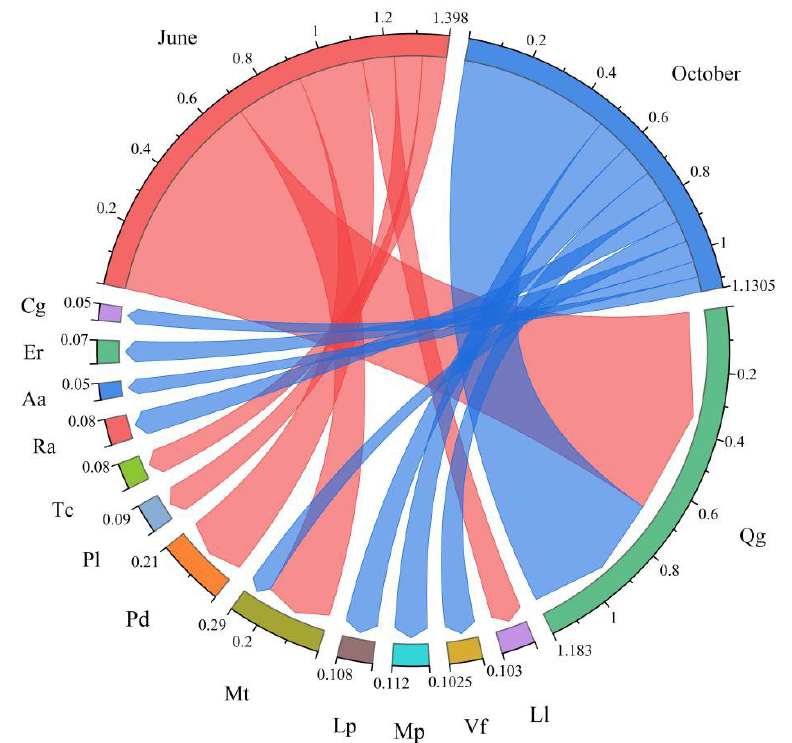
Figure 2. Importance value of dominant species (the pink arrow refers to the data of June, the blue arrow refers to the data of October, the other colors refer to different vegetation species. Cg: Cymbopogon goeringii (Steud.) A. Camus., Er: Elsholtzia rugulosa Hemsl., Aa: Artemisia argyi H. Lév. and Vaniot; Ra: Rabdosia adenantha (Diels) Hara, Tc: Tripogon chinensis (Franch.) Hack., Pl: Potentilla leuconota D. Don, Pd: Paspalum distichum Linnaeus, Mt : Monogramma trichoidea J. Sm., Lp: Leptodermis potanini Batalin, Mp: Machilus pingii Cheng ex Yang, Vf: Vaccinium fragile Franch., Ll: Leontopodium leontopodi- oides (Willd.) Beauv., Qg : Quercus guyavaefolia H.